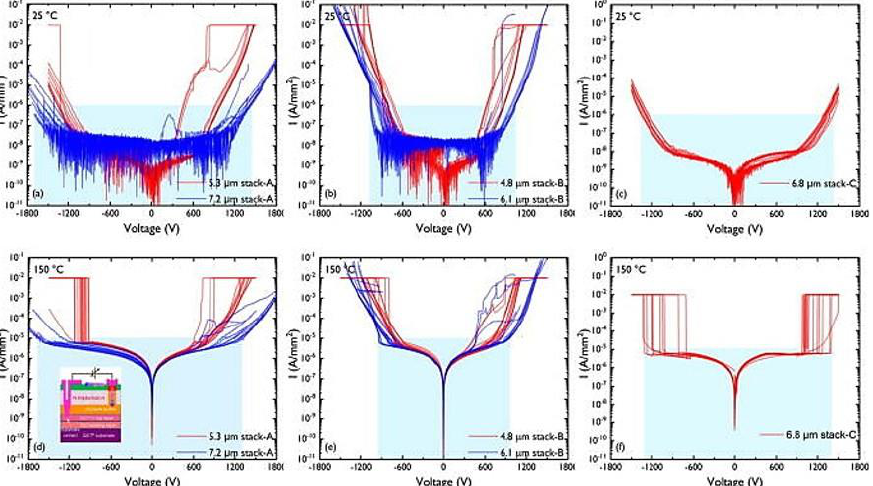
Figure 4. Vertical buffer leakage measurements for intrinsic C-doped ( a , d ) stack A (5.3 µm vs. 7.2 µm), ( b , e ) stack B (4.8 vs. 6.1 µm), and ( c , f ) stack C (6.8 µm) at 25 and 150 °C [81]. Figure reproduced with permission from AIP Publishing Applied Physics Letters.